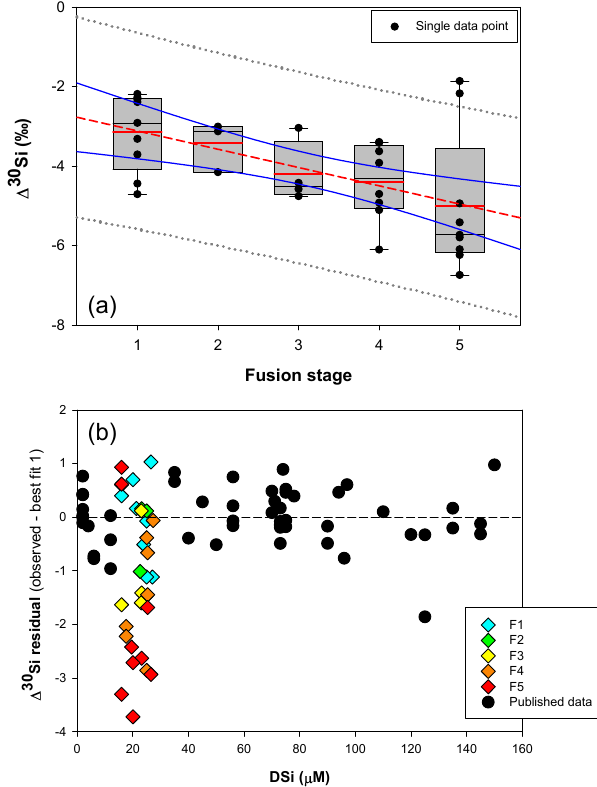
Figure 4. (a) Box plot showing the apparent Si isotopic fractiona- tion δ 30 Si by sponges as a function of spicule fusion degree: 1 for loose spicules (F1), 2 for net-like (F2), 3 for additional silica coat- ing (F3), 4 for dictyonal framework (F4) and 5 for dense dictyonal framework (F5). Red lines in the box plots are the mean of each pop- ulation and black is the median. The boxes define the 25th and the 75th percentiles and the error bars are the 10th and 90th percentiles. Black circles show a single sample for each of the fusion stages and the red dashed line shows the significant linear relationship between δ 30 Si and the fusion stage of the spicule ( n = 33, p < 0 . 0011). The blue lines represent the 95% confidence band and the grey short dashed lines the 95% prediction band. Data plotted here correspond to the samples from the equatorial Atlantic with an identified fusion stage, i.e. coloured diamond of (b) , and so occupy a very narrow range of DSi. (b) δ 30 Si residual of samples with an identified fu- sion stage compared to the published calibration (best fit